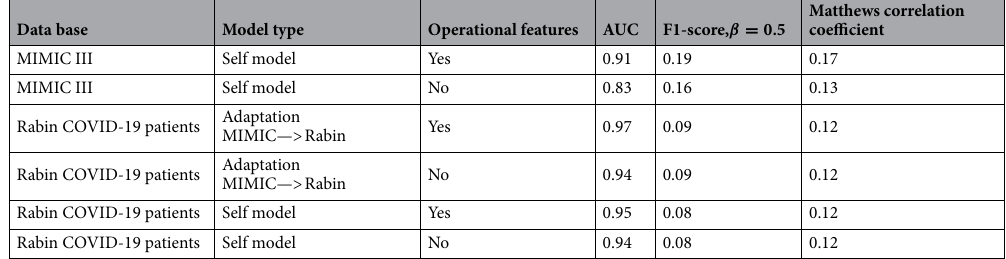
Table 2. Different operational characteristics for computational experiments. β = 0.5 —recall twice more important than precision. Matthew correlation coefficient (MCC) takes into account true and false positives and negatives and is generally regarded as a balanced measure which can be used even if the classes are of very different sizes. The MCC is in essence a correlation coefficient between the observed and predicted binary classifications; it returns a value between − 1 and + 1. A coefficient of + 1 represents a perfect prediction, 0 no better than random prediction and − 1 indicates total disagreement between prediction and observation. The F 1 score is the harmonic mean of the precision and recall. The more generic F β score applies additional weights, valuing one of precision or recall more than the other. The highest possible value of an F-score is 1.0, indicating perfect precision and recall, and the lowest possible value is 0, if either the precision or the recall is zero.